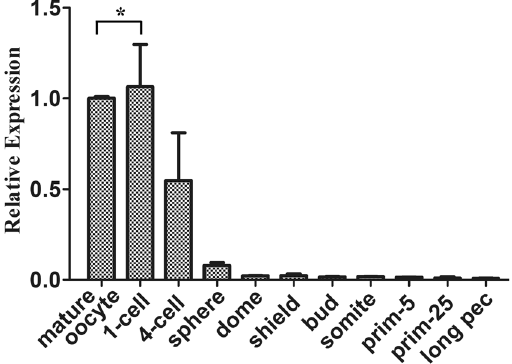
Figure 2. Temporal expression of miR-202-5p in mature oocytes and embryos at different development stages. U6 was used as an internal control. Asterisk indicated significant difference ( p <